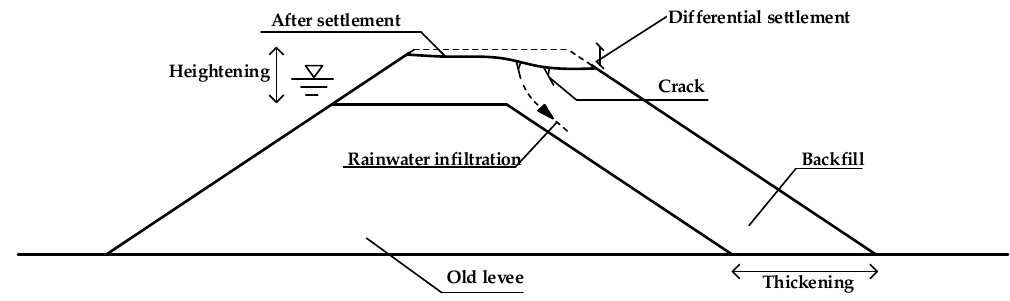
Figure 2. Generalization model of heightening and thickening levees (HTL).